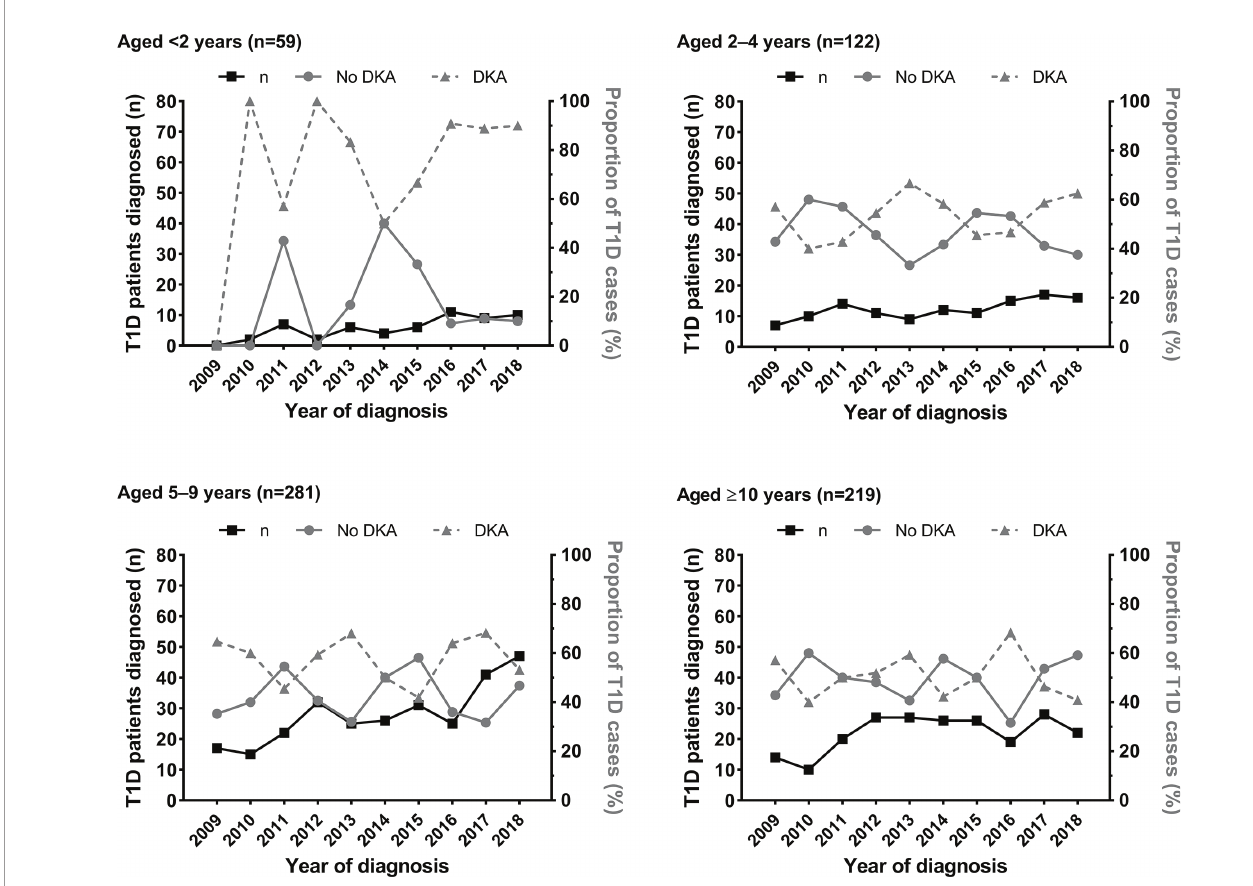
FIGURE 2 | Number of patients aged <16 years newly diagnosed with type 1 diabetes (T1D) at the Children ’ s Hospital of Zhejiang University School of Medicine (Hangzhou, China) in 2009-2018 according to age group, and rates of diabetic ketoacidosis (DKA) at diagnosis. Data are the number of patients newly diagnosed with T1D (black line, left y axis), and the respective rates of DKA (solid grey line, right y axis) and no-DKA (dashed grey line, right y axis) at T1D